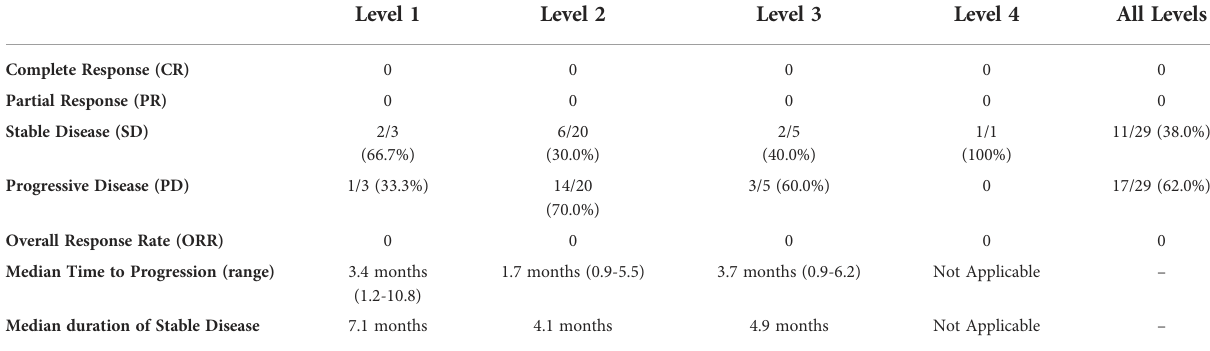
TABLE 4 Investigator assessed RECIST v1.1 response by Dose Level.